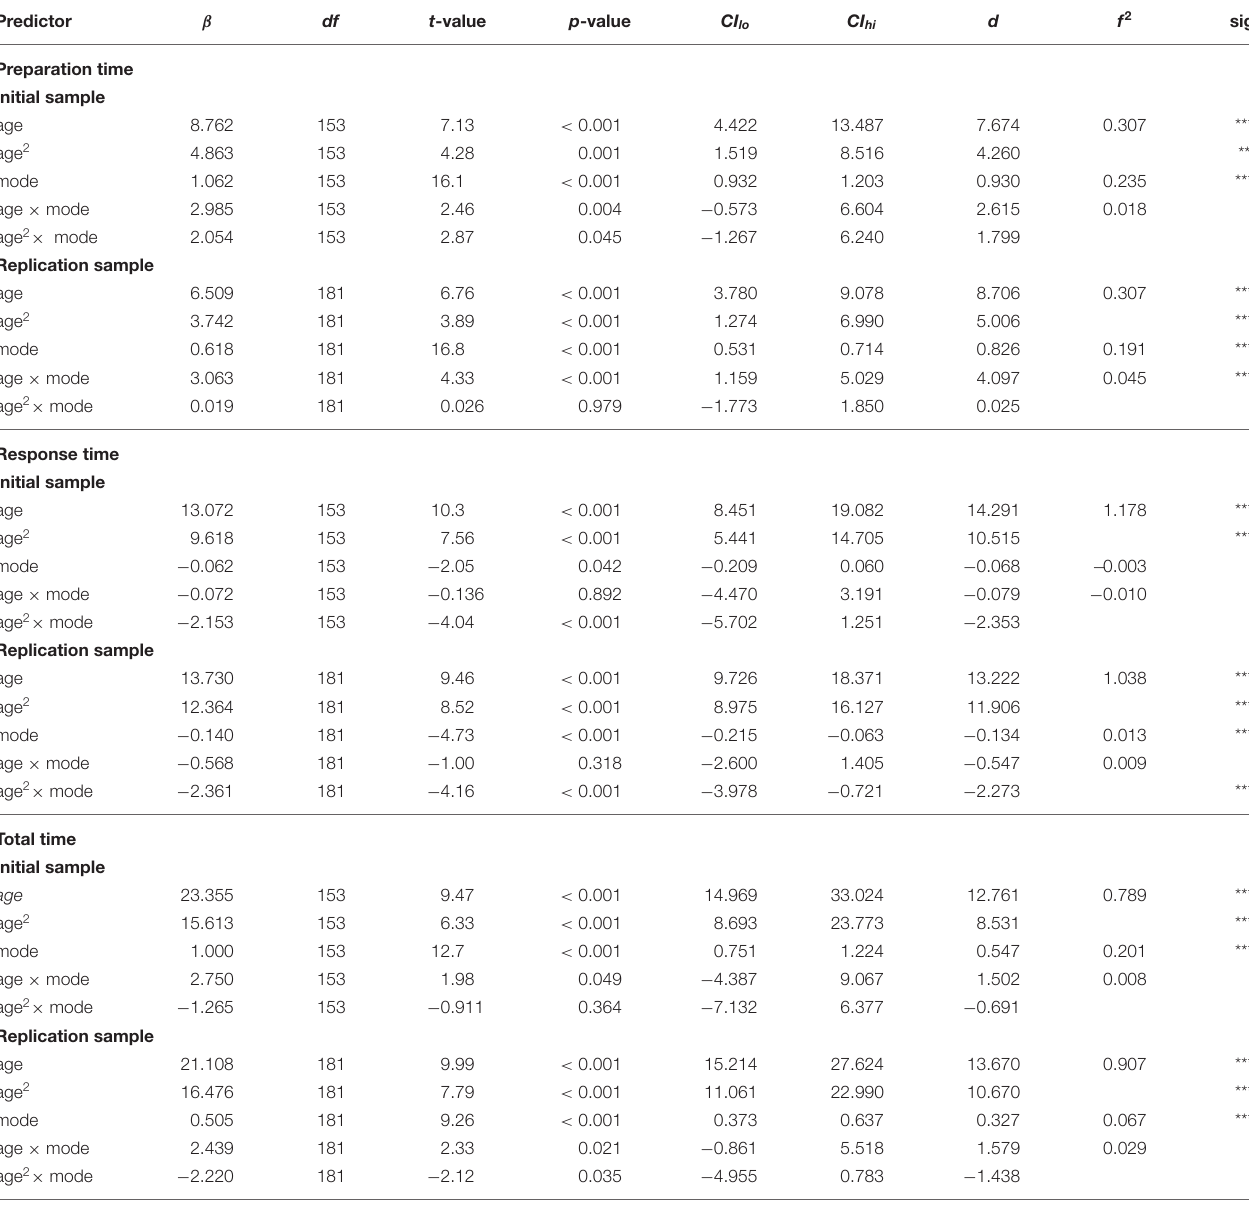
TABLE 4 | Summary of robust hierarchical linear modeling analyses for preparation time, response time, and total time across lifespan. Predictor